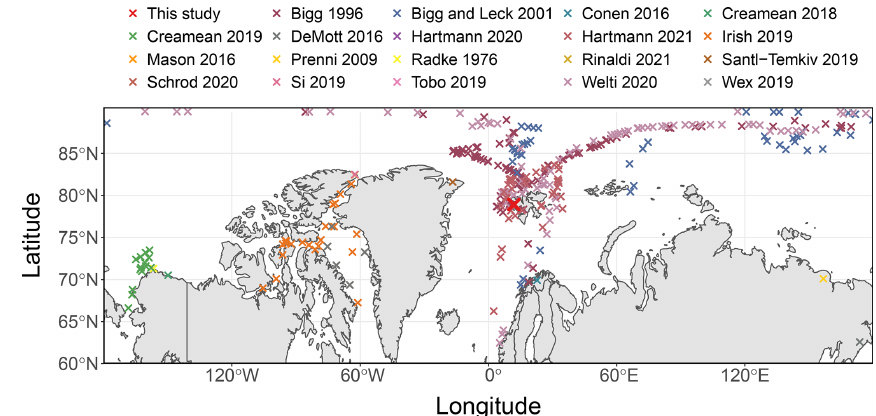
Figure 7. Locations of the previous Arctic field observations of INP concentrations used for evaluating the INP parameterization. More details of the observations of the individual campaigns are presented in Table S3 in the Supplement.